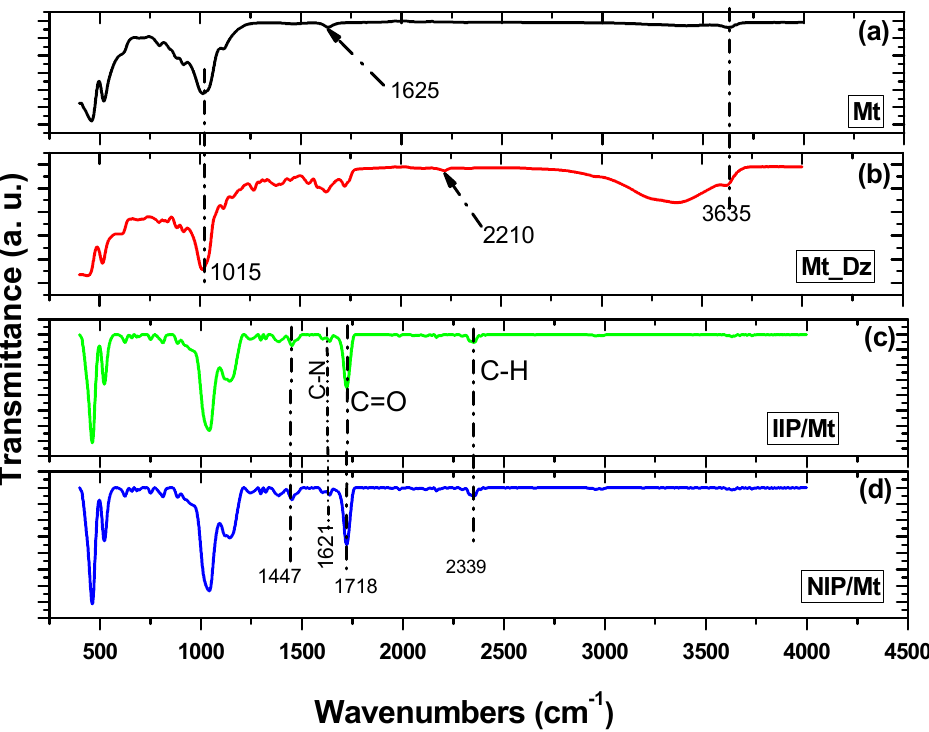
Figure 2. FTIR spectra of Mt ( a ), diazonium-modified montmorillonite, Mt_DZ ( b ), IIP/Mt ( c ), and NIP/Mt ( d ).